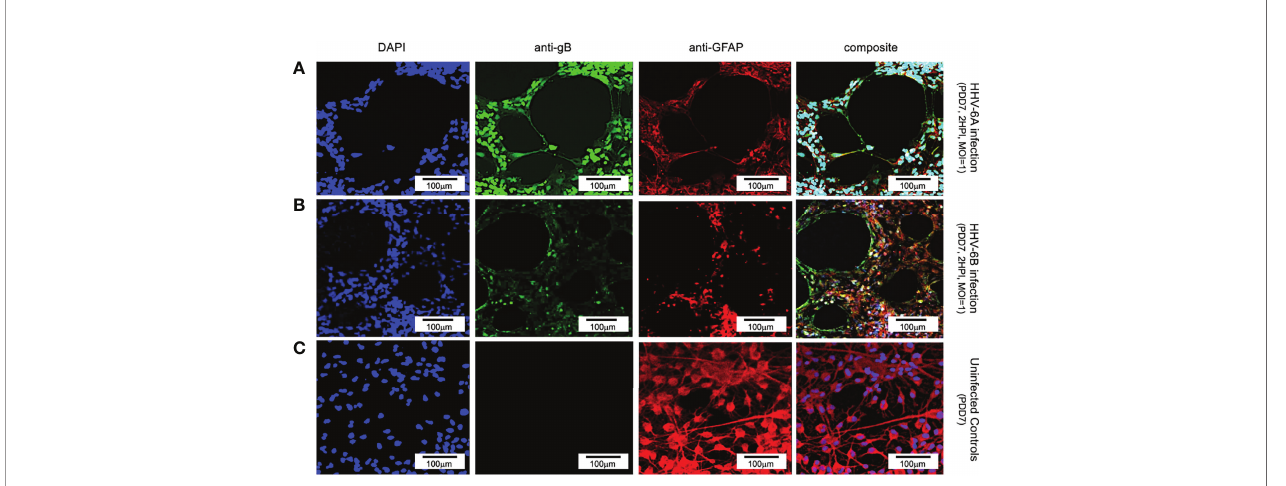
FIGURE 1 | Fluorescence microscopy images of dHNSC treated with immuno fl uorescent antibodies and a fl uoro-dye at PDD7: Differentiation to glial cells. From left to right, DAPI, anti-gB, anti-GFAP, and composites. PDD7 HNSC infected with HHV-6A (row A ) show gB-positive signal on GFAP-positive cells (glial cells). PDD7 HNSC infected with HHV-6B (row B ) also show gB-positive signal on GFAP-positive cells. Images for uninfected control culture (row C ) show welldeveloped GFAP- positive cells with homogeneous distribution; many exhibit stellate morphotypes. [Scale bar = 100